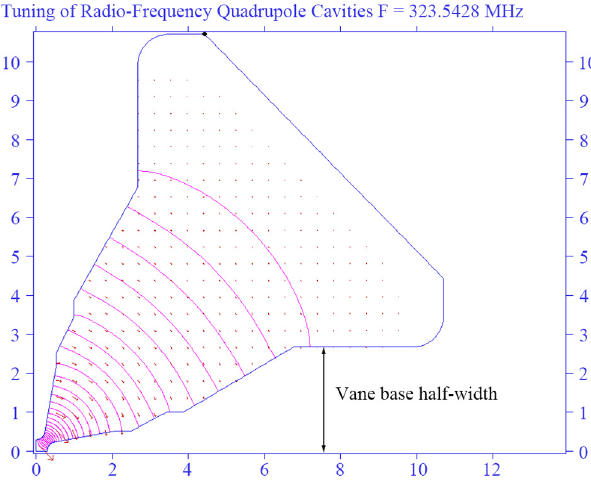
FIG. 4. Cross section of the RFQ at z ¼ 33 . 2 cm with the field calculated by the SUPERFISH code.